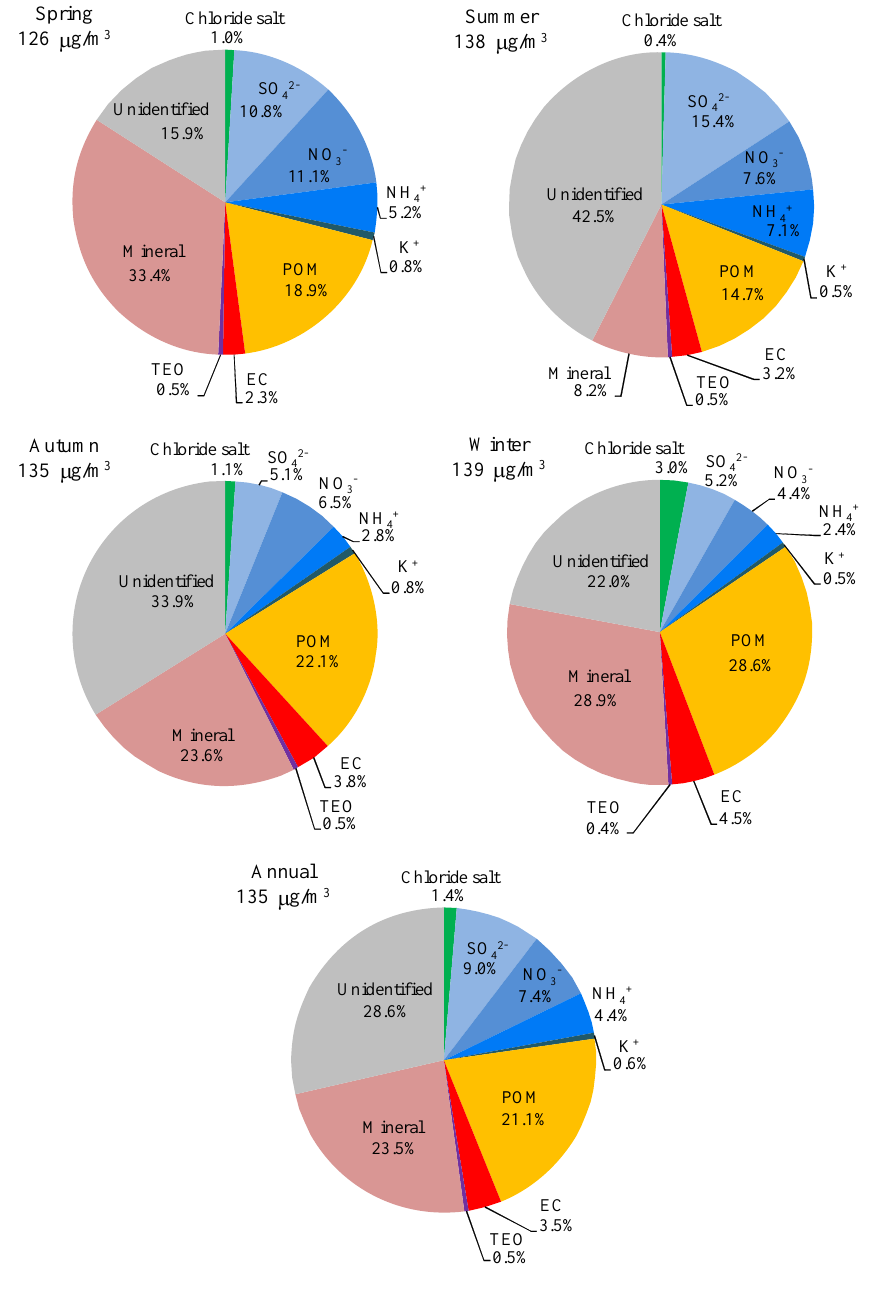
Figure 7 Fig. 7. Pie-charts showing the constructed chemical mass closures for PM 2 . 5 in Beijing: (a) spring; (b) summer; (c) autumn; (d) winter; and (e) annual. The components include mineral dust, secondary aerosol ions (sulfate, nitrate, and ammonium), POM, EC, trace element oxides (TEO), chloride salt, and biomass burning-derived potassium. Other than the identified components, unidentified fractions comprise a significant portion of PM 2 . 5